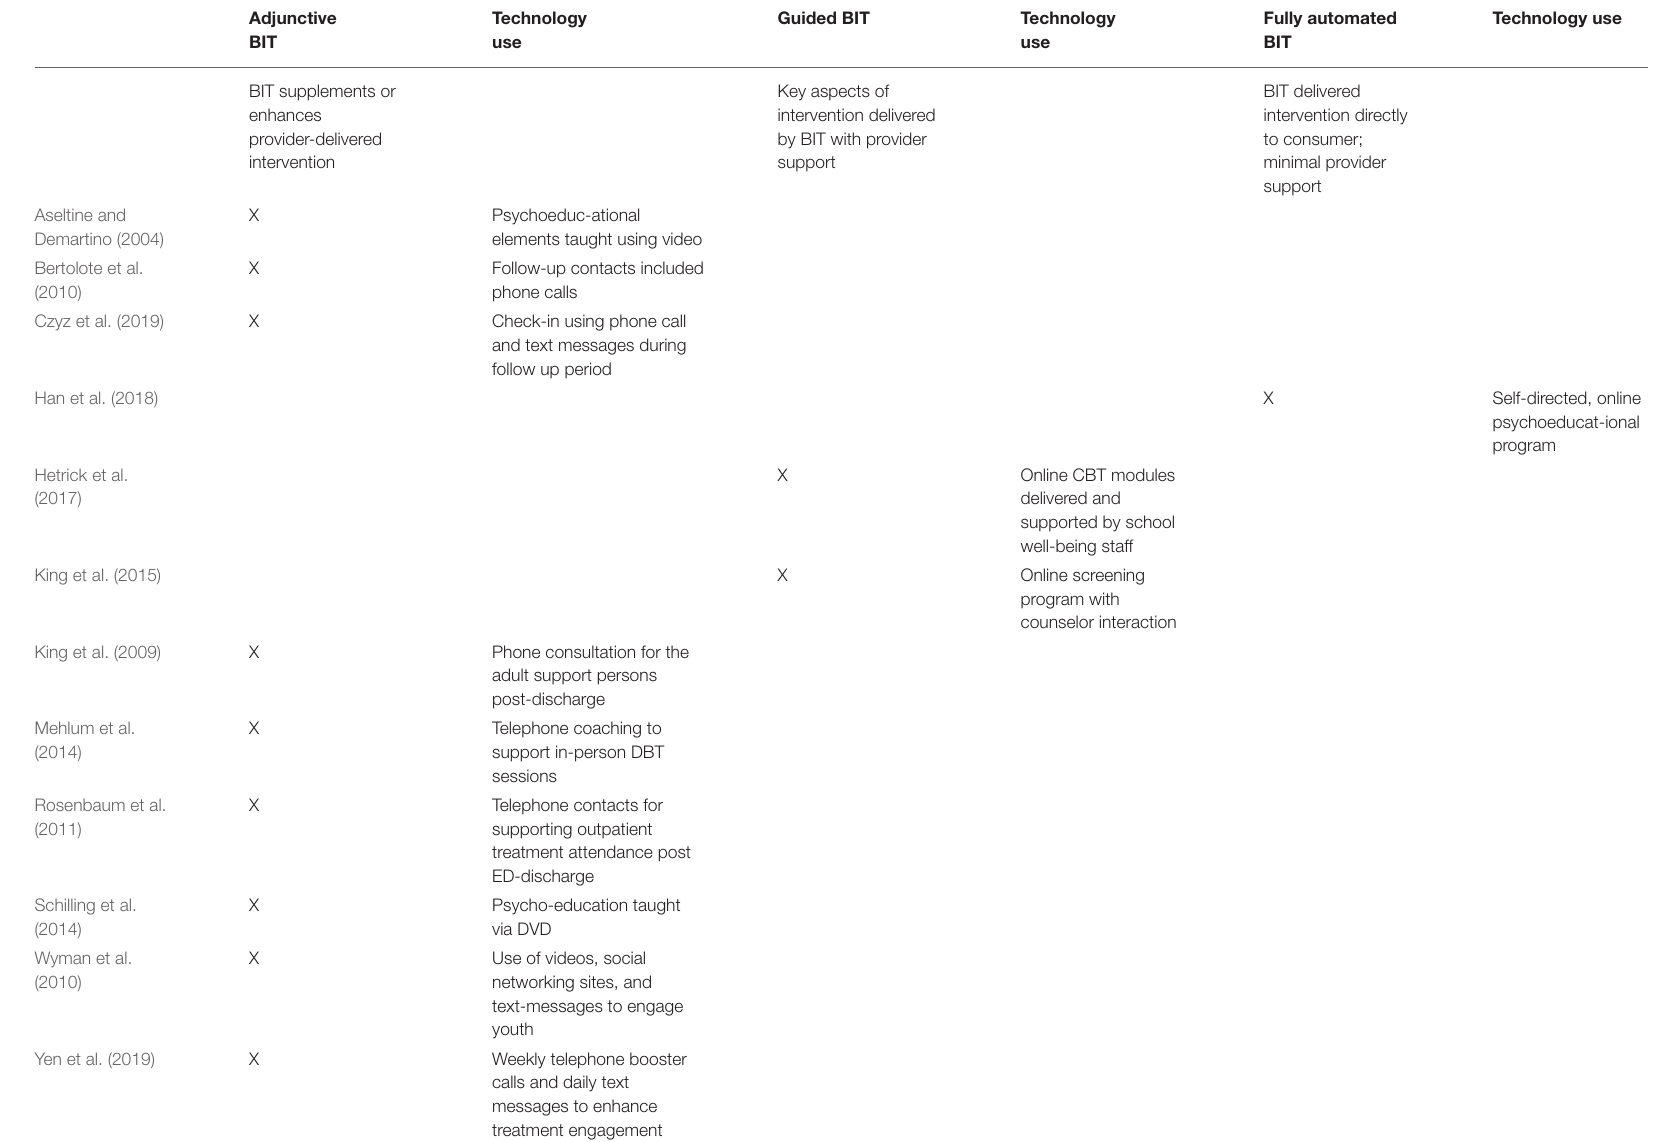
TABLE 2 | The Continuum of Behavioral Intervention Technology (BIT) and use of